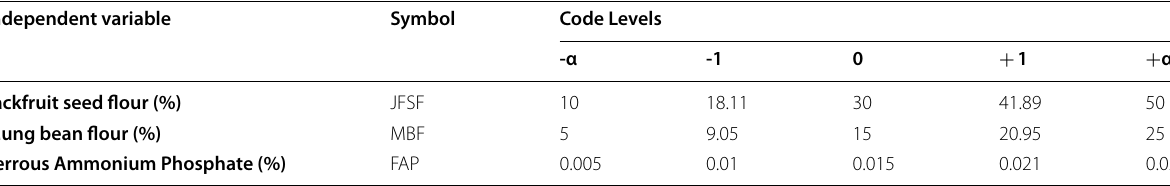
Table 1 Independent variables and their corresponding levels for iron rich extruded snack Independent